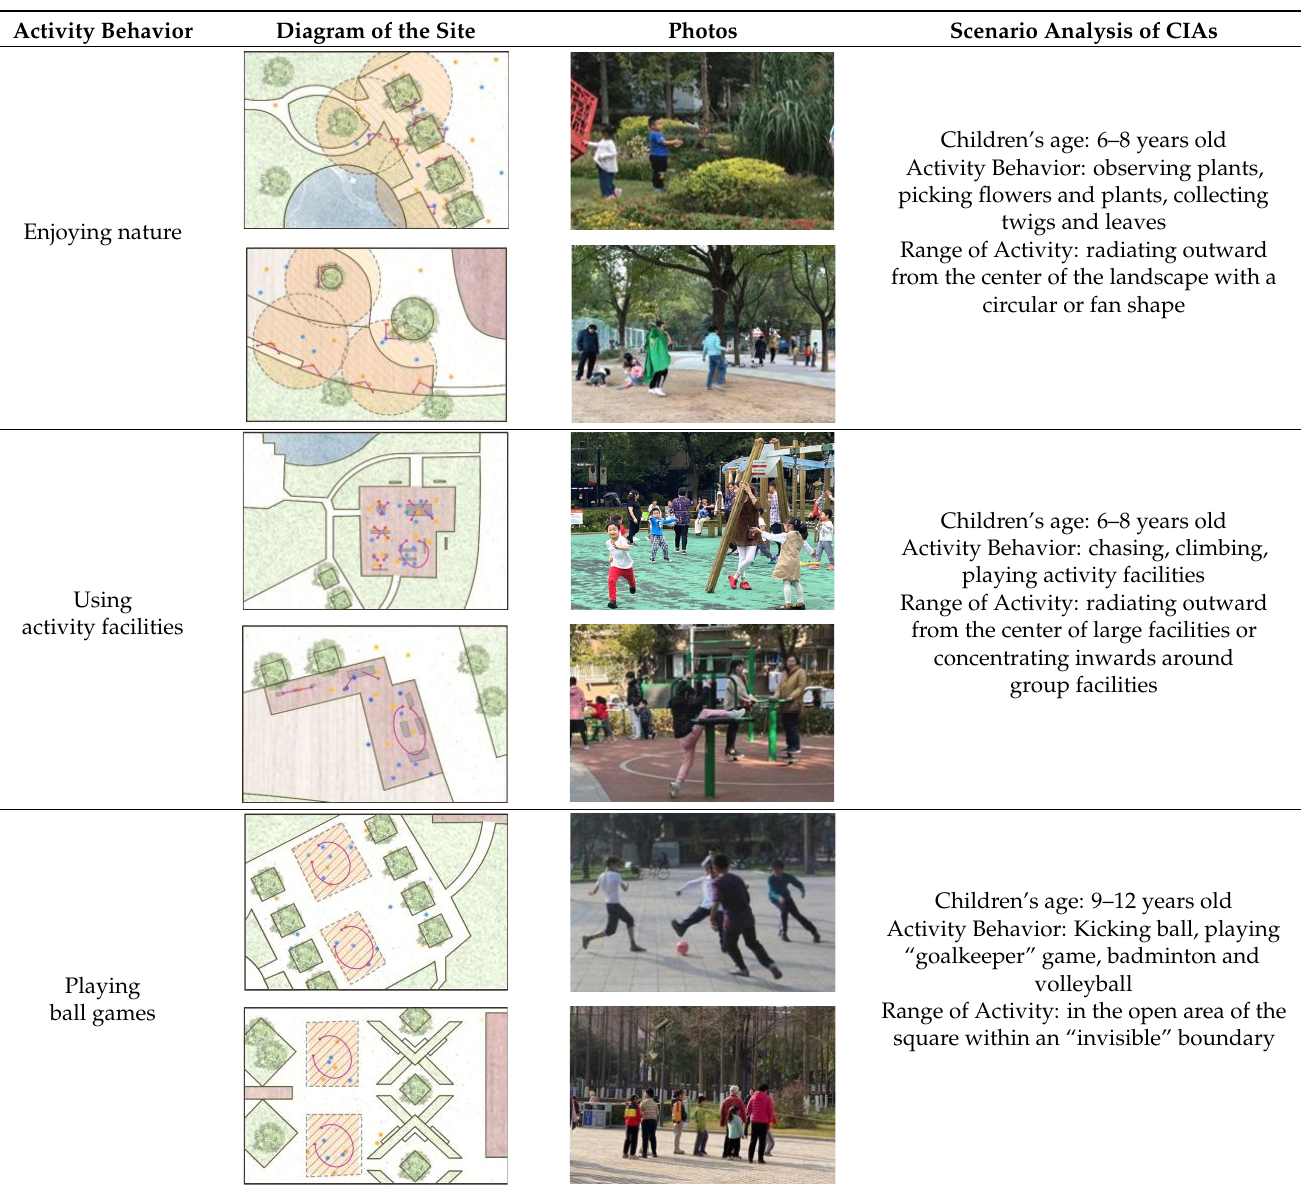
Table 5. Scenario analysis of CIAs.